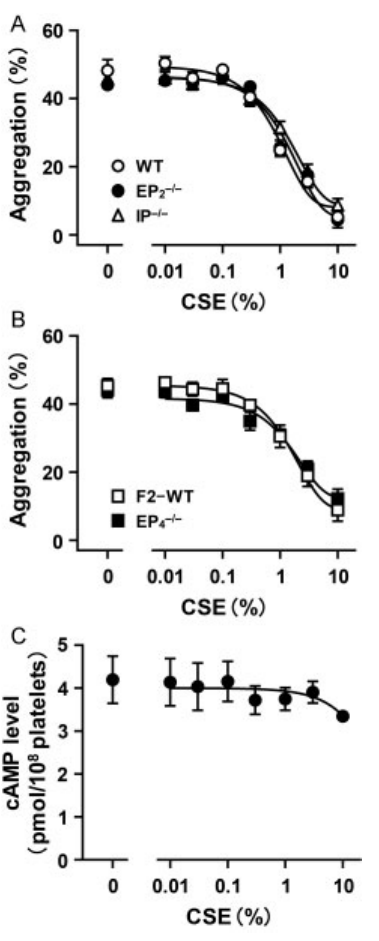
Fig. 3 Nonparticipationofinhibitoryprostanoidreceptorsintheinhibitory effect of cigarette smoke extract (CSE) on platelet aggregation. ( A, B ) Effects of CSEon U-46619-inducedaggregation in platelets prepared from WT, EP 2 – / – , and IP – / – mice ( A ) and from F2-WT and EP 4 – / – mice ( B ). U-46619 was added at a concentration to induce platelet aggregation of 40 to 55% (2.5 – 3.5 μ M). CSE was added at the indicated concentration to PRP 1 minute before the addition of U-46619. Each value is the mean (cid:1) SEM. WT, n ¼ 6; EP 2 – / – , n ¼ 7; IP – / – , n ¼ 6; F2-WT, n ¼ 5; EP 4 – / – , n ¼ 8.( C )EffectsofCSEoncAMPproductioninplatelets.IBMX(1mM)was added to washed platelets 10 minutes before the addition of CSE, which was added at the indicated concentration and incubated for 10 minutes. Each value is the mean (cid:1) SEM, n ¼ 4.